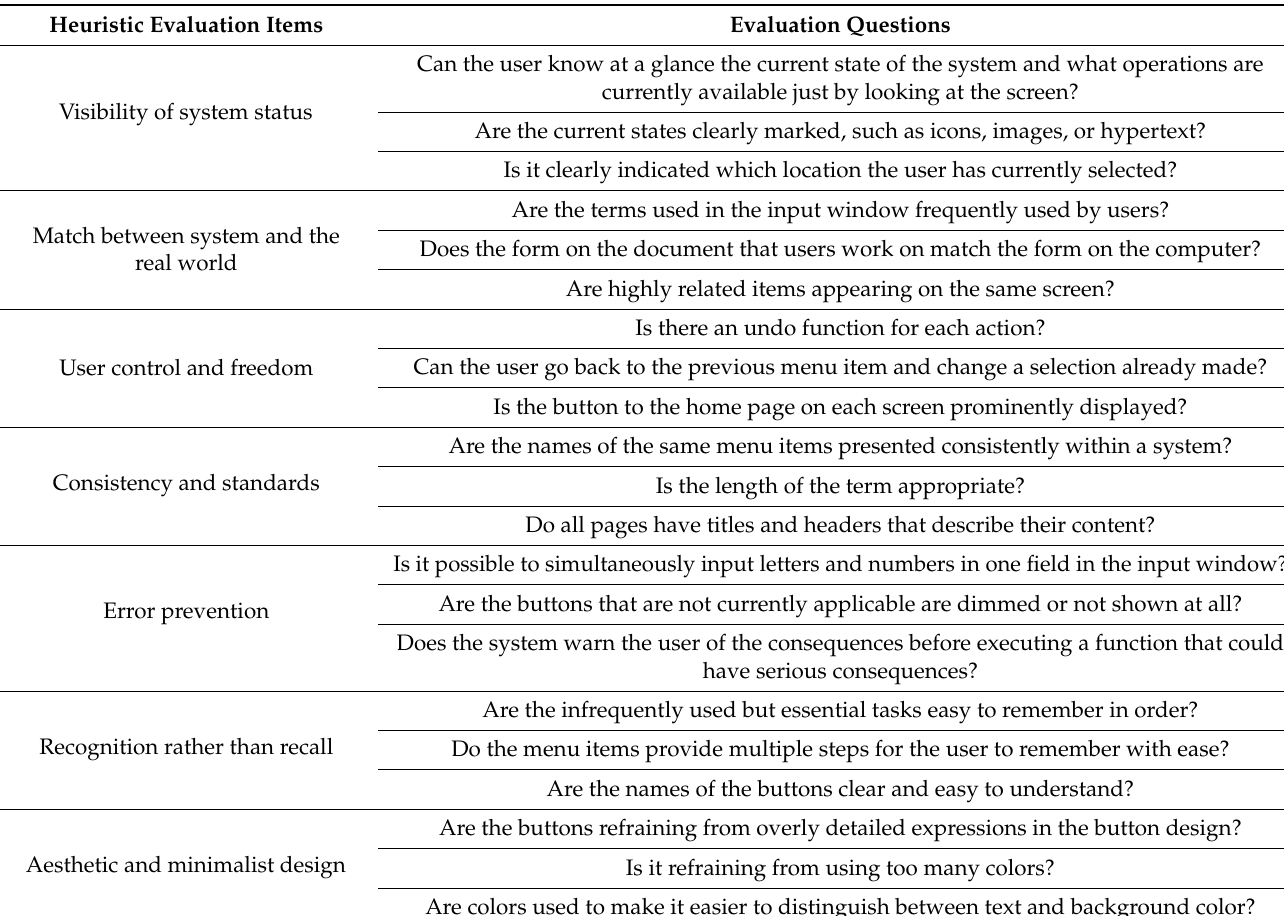
Table 4. Contents of the questionnaire for heuristic